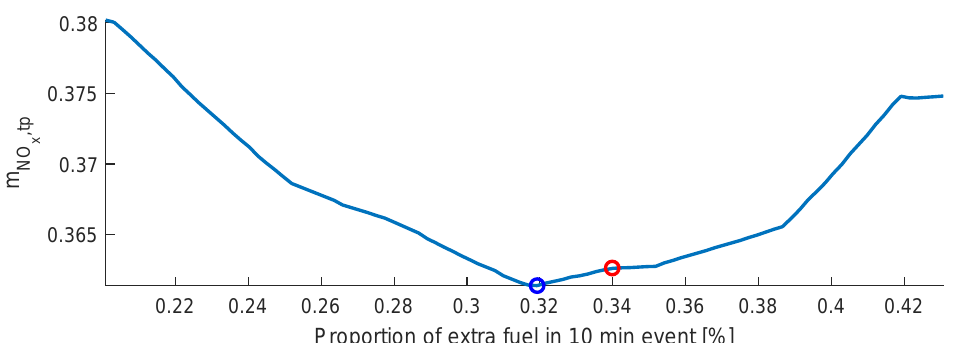
= 0.58 in Figure 10. x